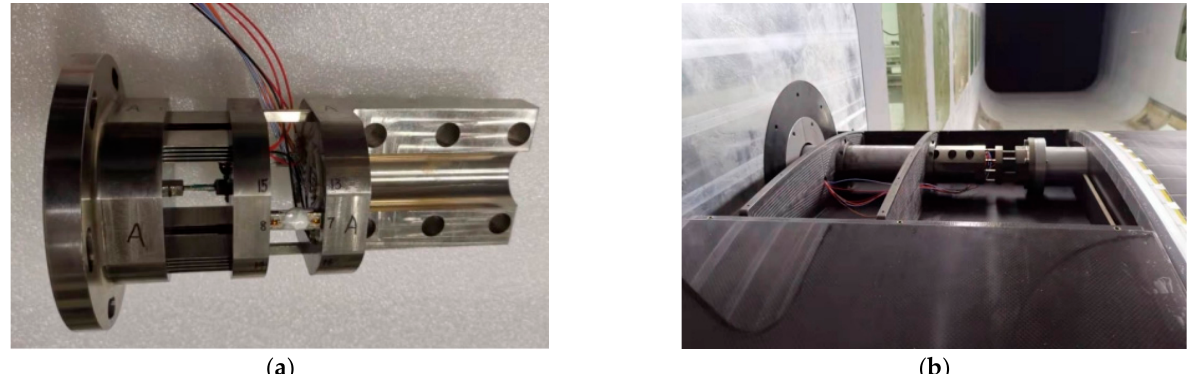
Figure 5. Balance structure and installation method: ( a ) Three-component force-measuring balance; ( b ) Installation of balance and wing.